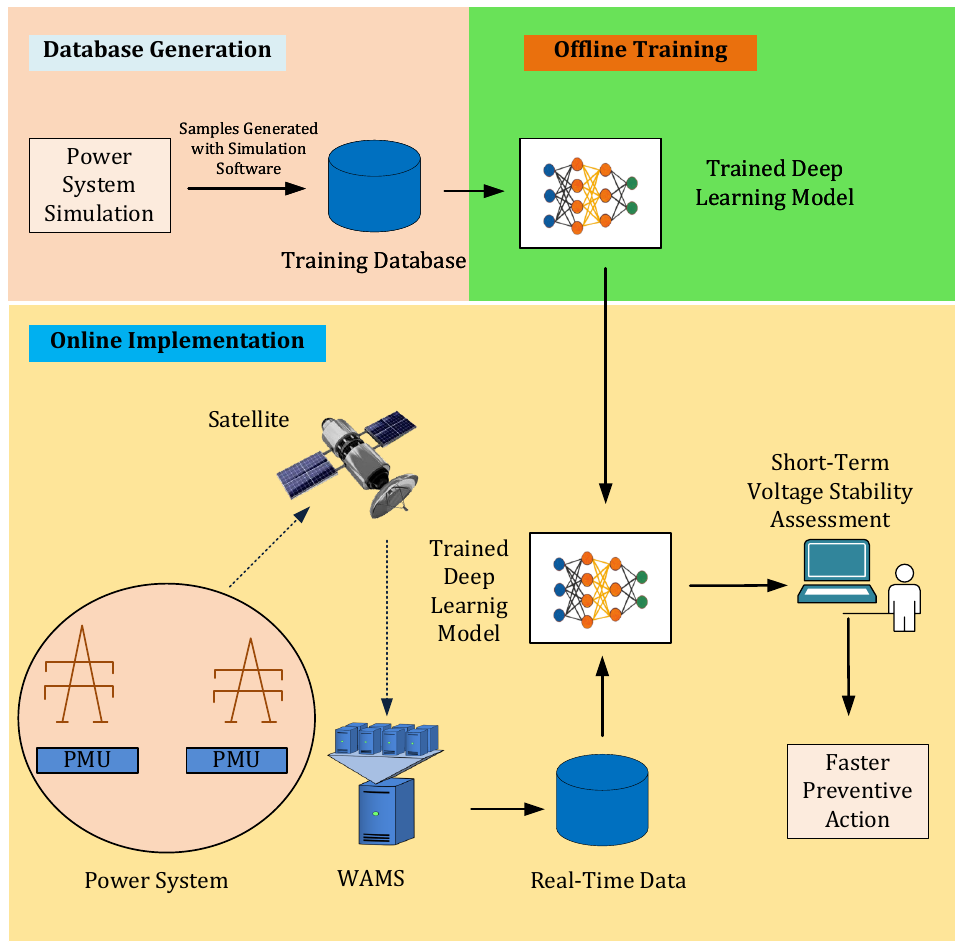
Figure 1. A general approach of real-time STVS